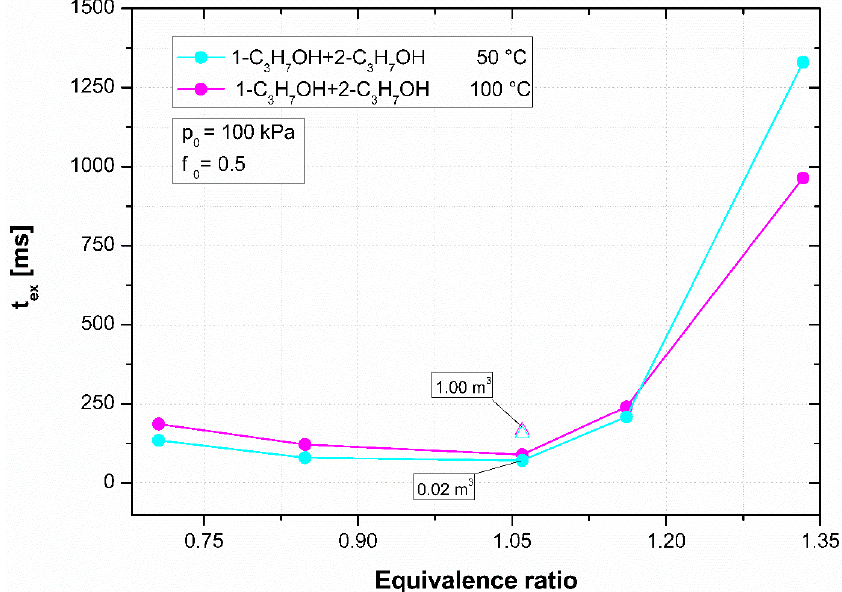
Figure 11. t ex versus Φ = 0.7–1.3 for 1-propanol/2-propanol–air mixtures at various initial temperatures and mixture compositions, p 0 = 100 kPa.